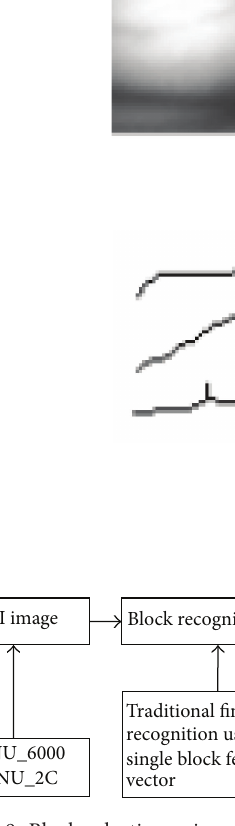
Figure 9: Block selection using contribution of block location by looking at recognition rate of each block